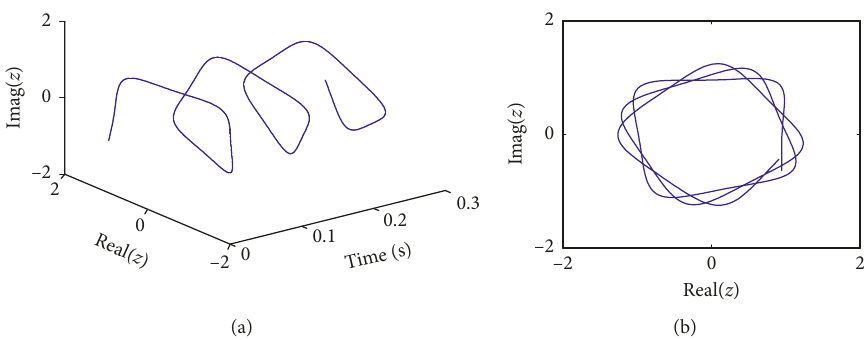
Figure 1: The simulated signal of z : (a) the three-dimensional time-domain waveform; (b) the two-dimensional plots.